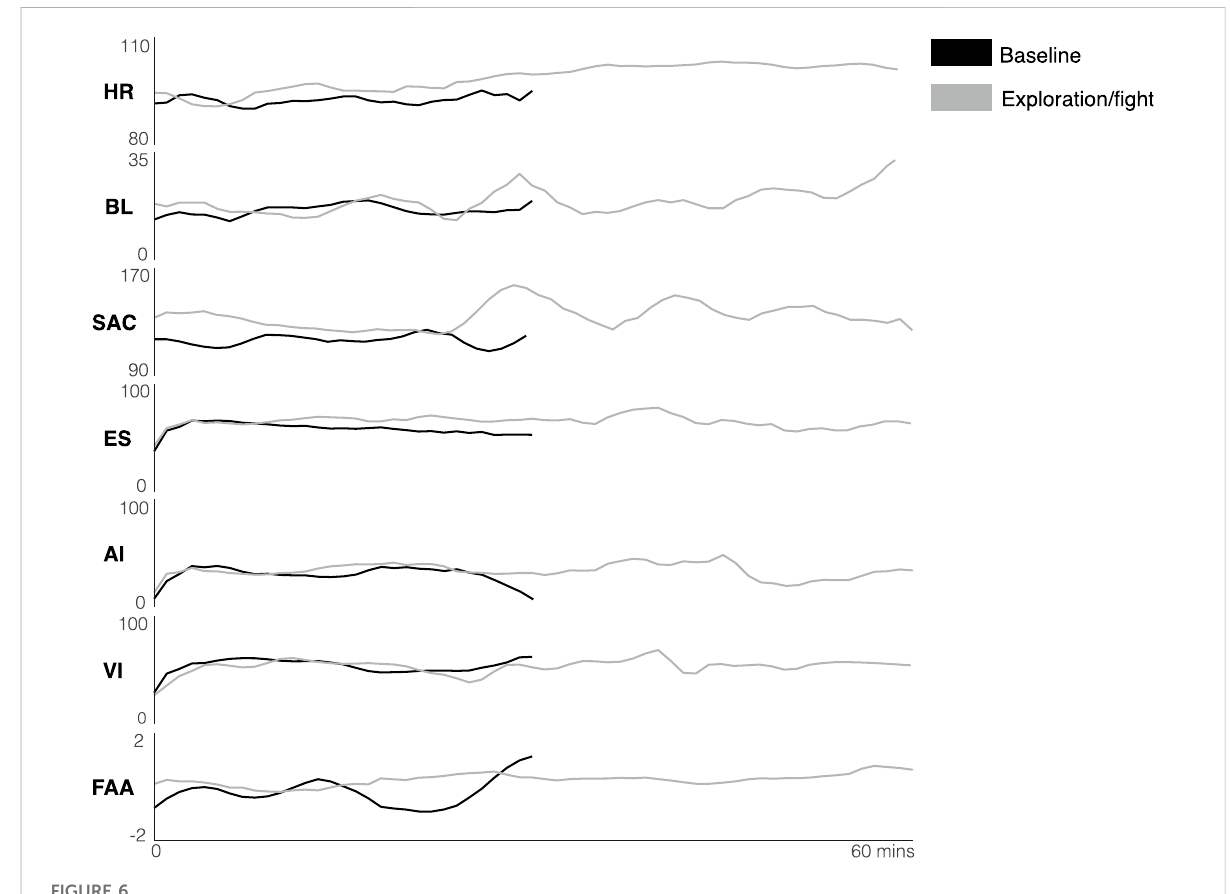
FIGURE 6 Instrumental measures over time in baseline (black) and exploration/ fi ght (grey) conditions for all participants.